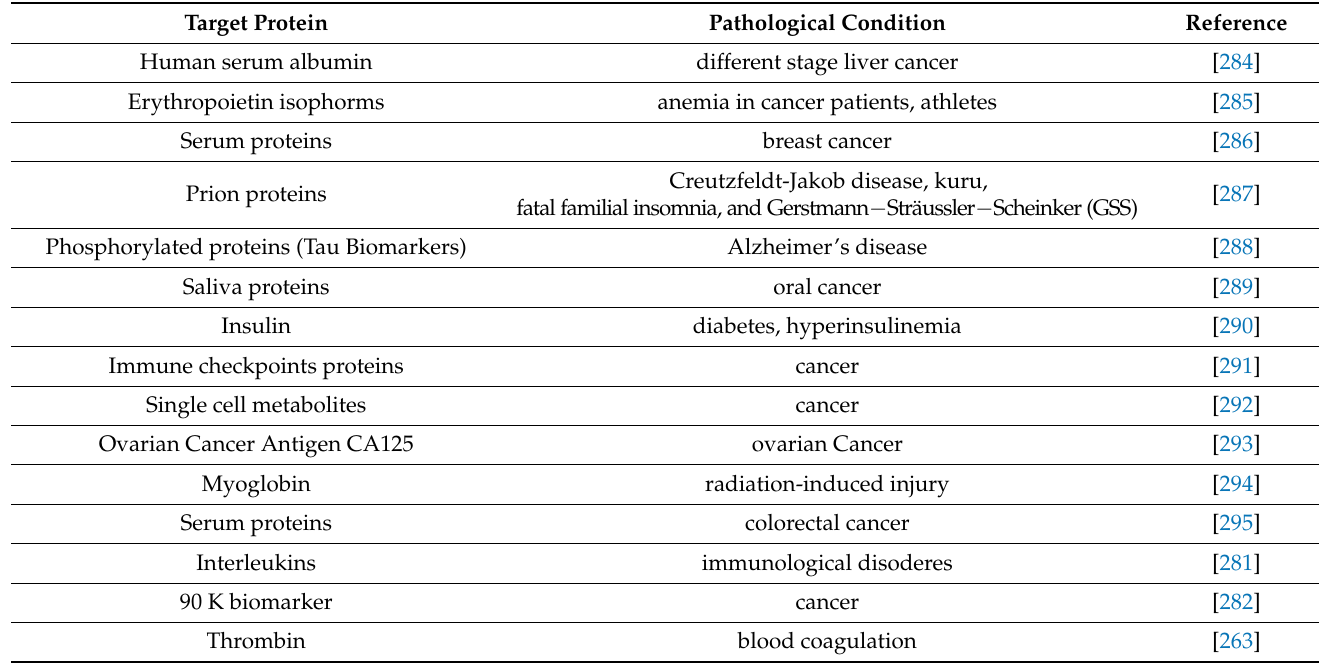
Table 6. Application of label-free SERS for detection of proteins in microfluidic devices. Target